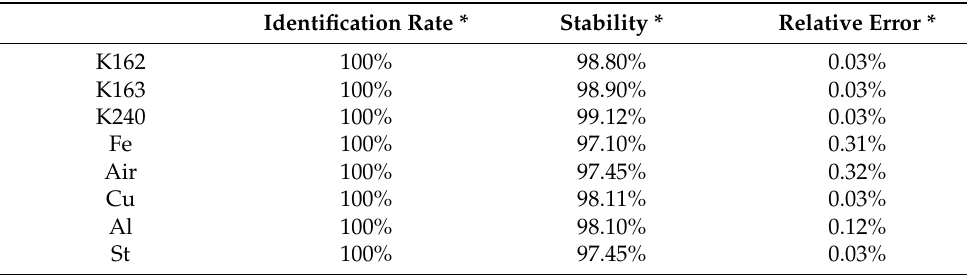
Table 4. The identification rate of the sensor, the stability of the calculation model and the accuracy of the evaluation